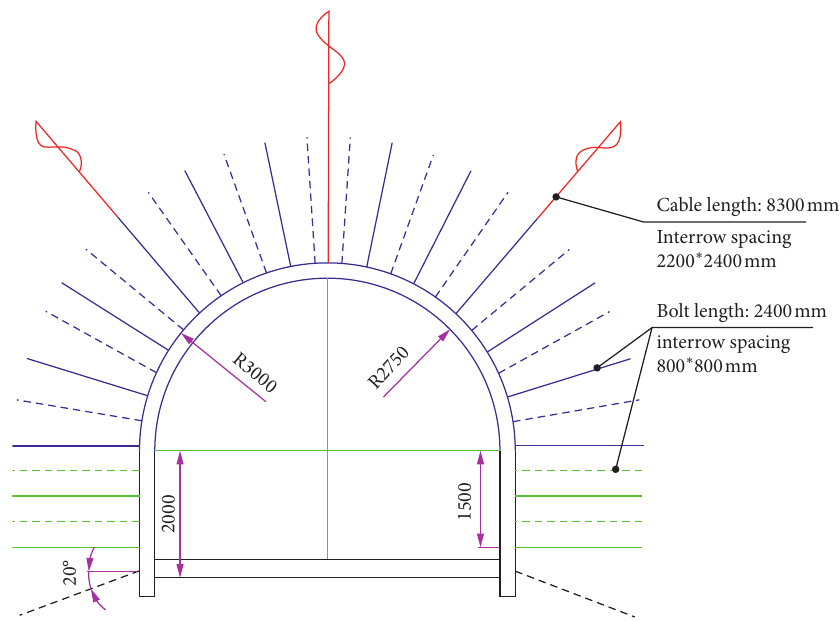
Figure 16: Bolt (anchor cable) layout in the roadway section.